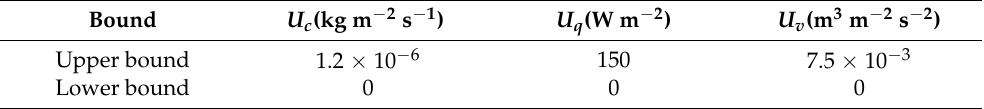
Table 2. Bounds of control